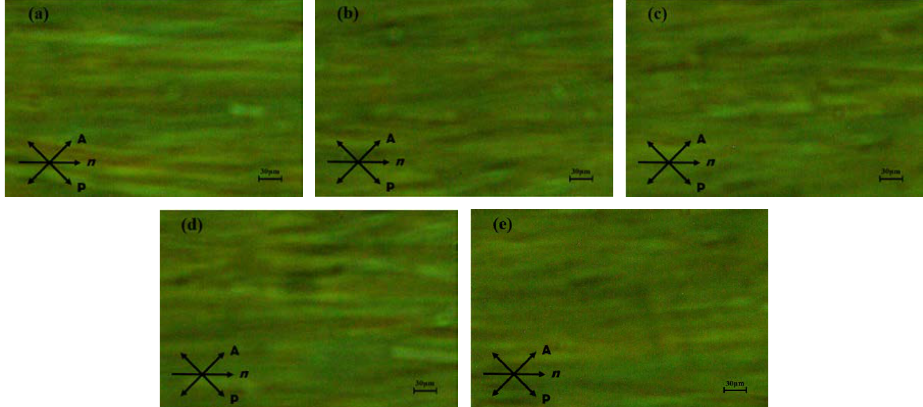
Figure 2. The polarized optical microscope (POM) images of parallel-aligned nematic (PAN) cell with and without γ -Fe 2 O 3 nanoparticles. ( a ) 0.00 wt%; ( b ) 0.02 wt%; ( c ) 0.05 wt%; ( d ) 0.08 wt%; and ( e ) 0.11